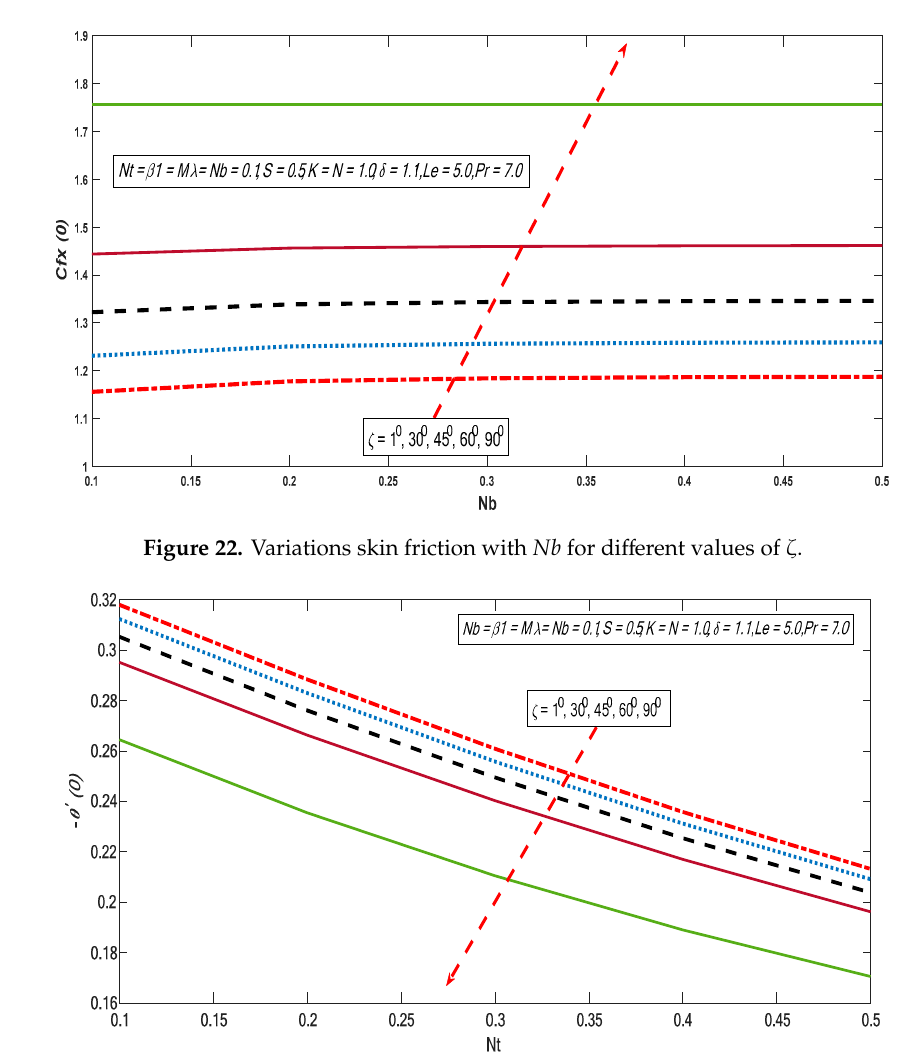
Figure 21. Variations of reduced Sherwood number with 𝑁𝑏 for different values of 𝜁 .